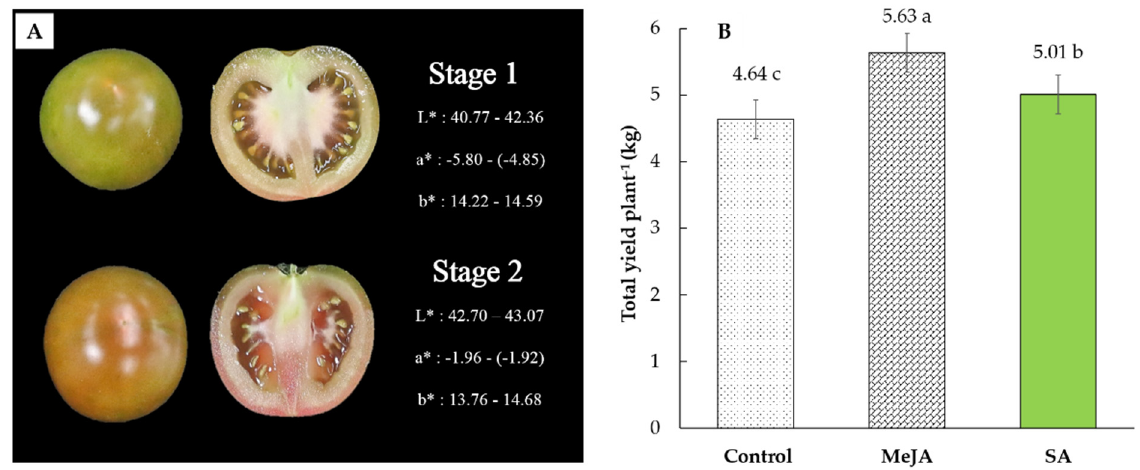
Figure 1. Harvesting stages ( A ) and total yield plant − 1 ( B ) of ‘Kumato’ tomato cultivar in the control and treatment (0.25 mM MeJA and 0.5 mM SA) groups. The color of fruit was determined using the Hunter a* (redness), b* (yellowness), and L* (brightness) values.